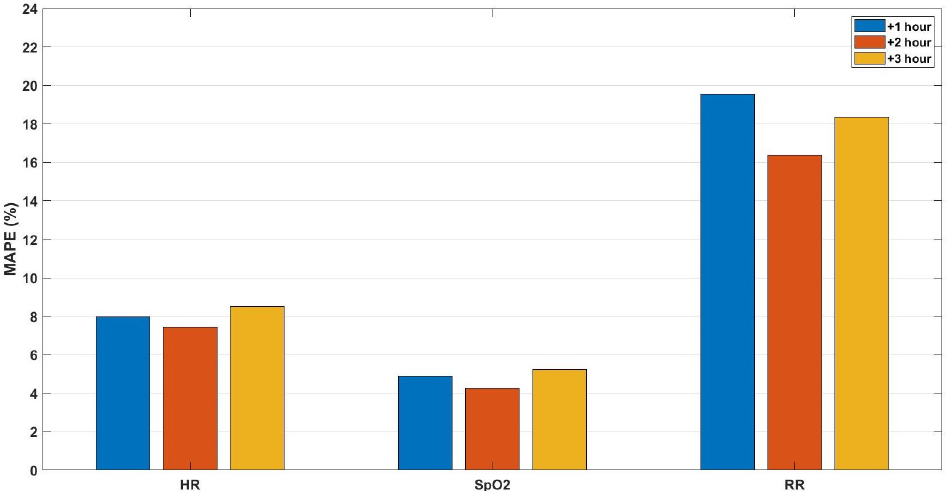
Figure 7. The mean absolute percentage error of the predictions for the upcoming three hours (+1, +2, +3 h) of the vital signs: heart rate (HR), oxygen saturation (SpO 2 ), and respiration rate (RR), respectively, based on an observation rate of one observation/5